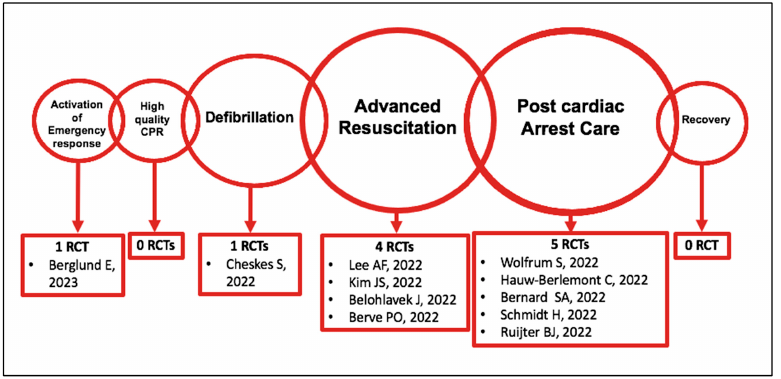
Figure 4. Number of randomized clinical trials published in 2022 for each link of the chain of survival [4,9,15,17,22,30,38,45,51,52,60,63,65].